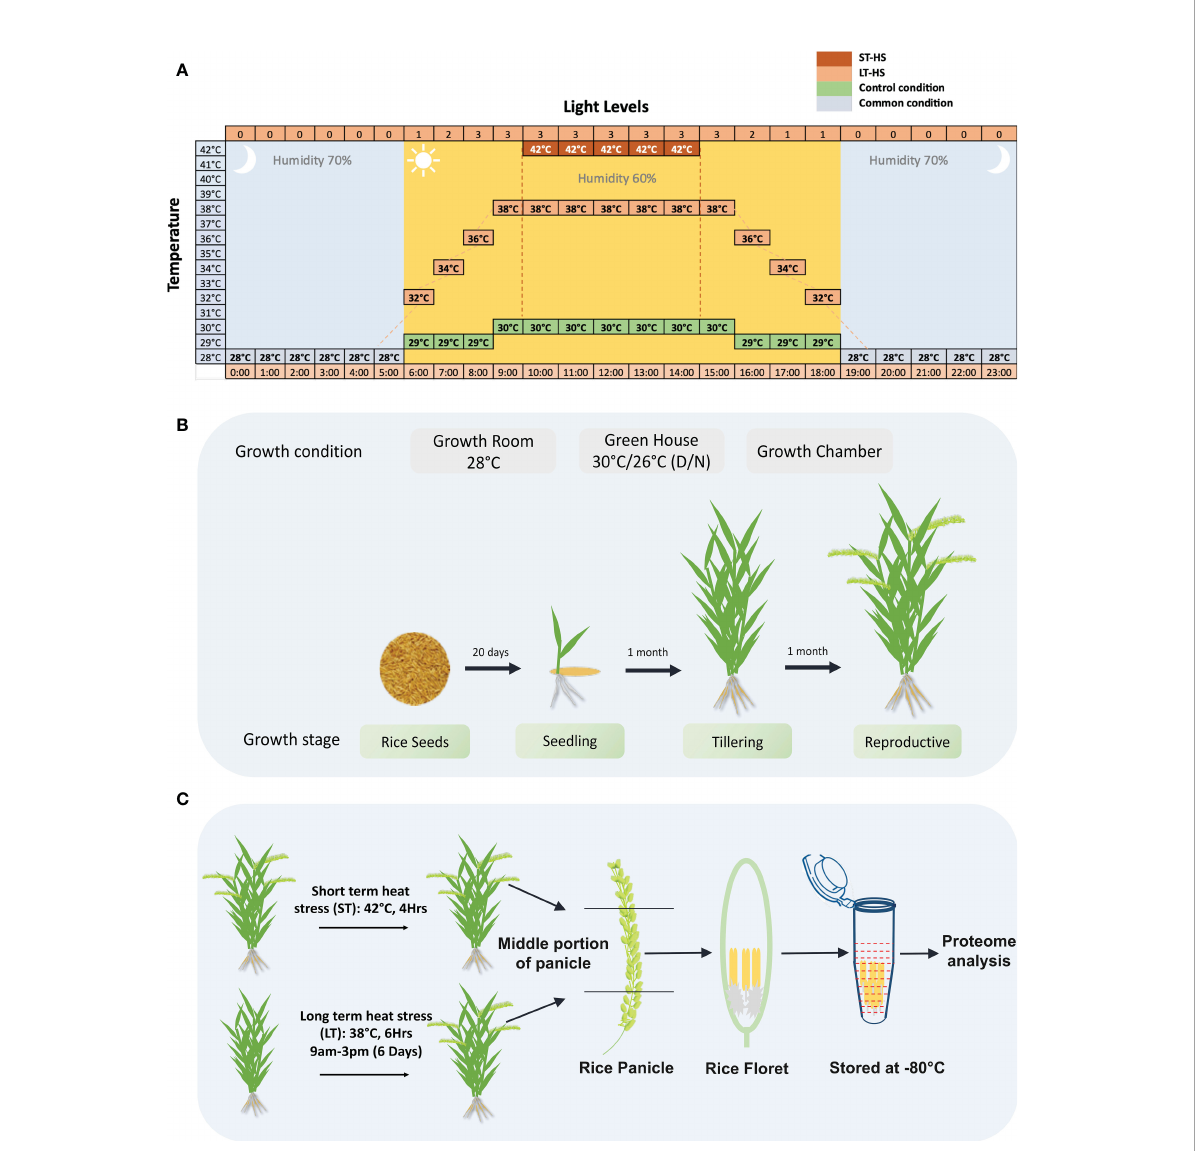
FIGURE 1 Details of the growth and stress conditions followed in the experiment. (A) Illustration showing the stress regimes used in the current study. In the short-term heat stress, plants were exposed to 42°C for 4 hours, and in long-term heat stress, plants were exposed to 38°C temperature for 6 hours. (B) Growth conditions for growing rice plants for the study. (C) The stress regimes used in ST-HS (short-term heat stress) and LT-HS (long-term heat stress) treatments followed for the proteome analysis are shown. The plants at the reproductive stage were stressed, and the anthers were dissected just before the